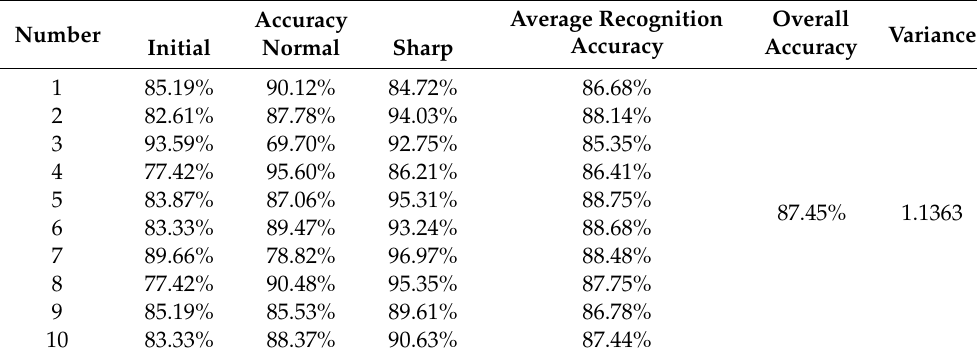
Table 5. The recognition accuracy of the tool wear condition based on time–domain analysis, frequency–domain analysis, and wavelet packet decomposition